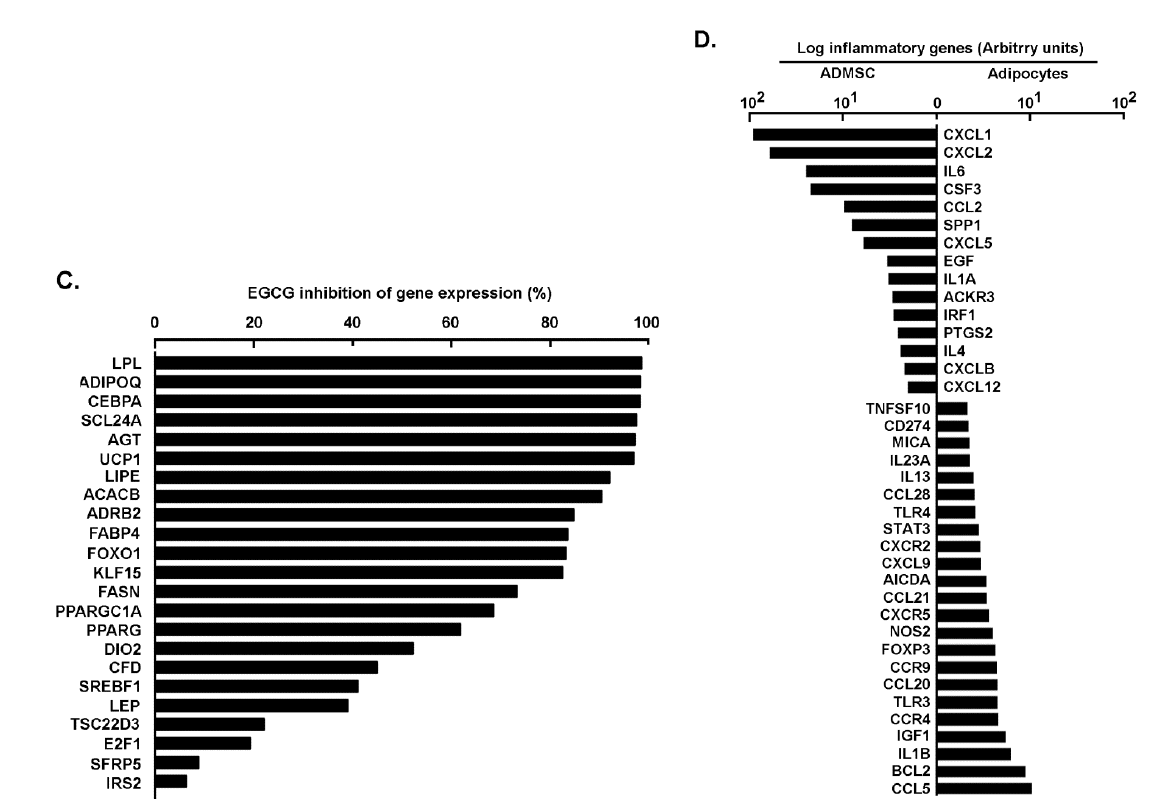
Figure 1. Transcriptional validation of ADMSC differentiation into adipocytes and green tea-derived EGCG inhibition of adipogenesis. ( A ) ADMSC were differentiated into mature adipocytes in the presence or not of 10 µ M EGCG as described in the Methods section. Oil Red O staining was performed at different stages of differentiation to confirm mature adipocyte status through lipid droplets formation, typically observed between day 6 and day 12. ( B ) Total RNA was extracted from ADMSC, adipocytes, as well as ADMSC differentiated in the presence or not of EGCG. RT-qPCR was performed using a RT 2 -Profiler gene array to assess adipogenesis gene expression levels. Ratios of adipocytes gene expression on ADMSC gene expression were performed and expressed in a logarithmic scale. ( C ) Ratios of adipocytes differentiated in the presence of EGCG on ADMSC were performed, and EGCG inhibitory potential calculated. ( D ) Total RNA was extracted from ADMSC and from adipocytes. RT-qPCR was performed using a RT 2 -Profiler gene array to assess inflammatory-associated gene expression levels. Ratios of adipocytes/ADMSC gene expression (right), and ADMSC/adipocytes (left) gene expression were performed and expressed in a logarithmic scale. Gene arrays data reflect one representative experiment out of two.